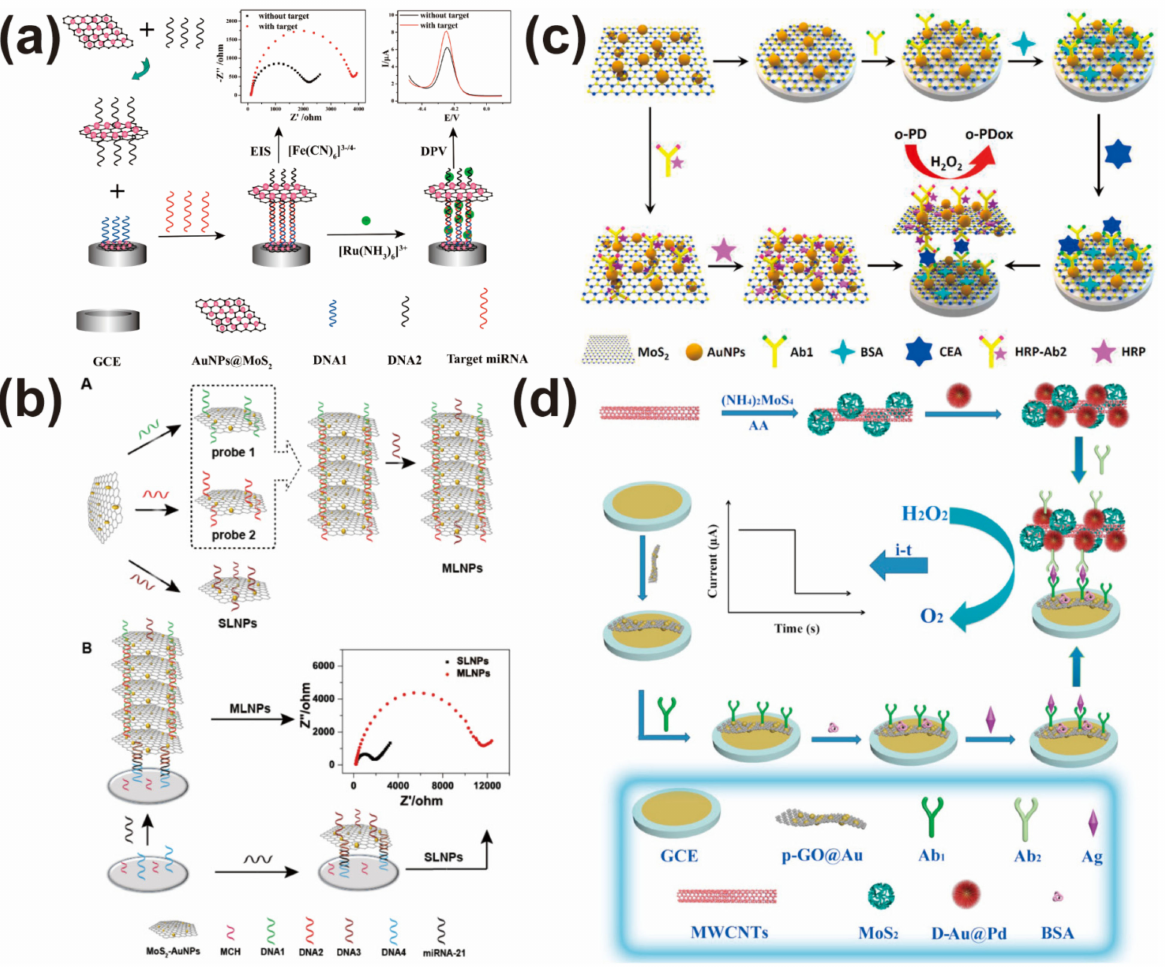
Figure 2. ( a ) Construction of dual-mode electrochemical sensor for miRNA-21 detection based